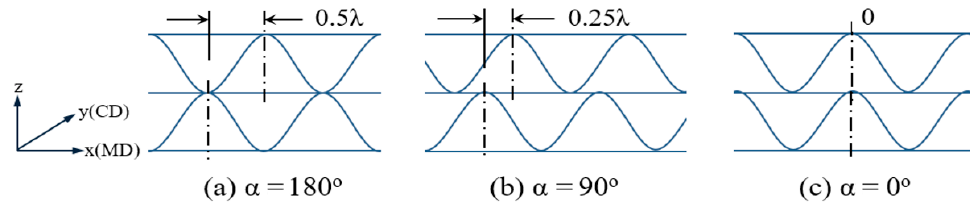
Figure 2. Meshed 3D models for FE simulation.